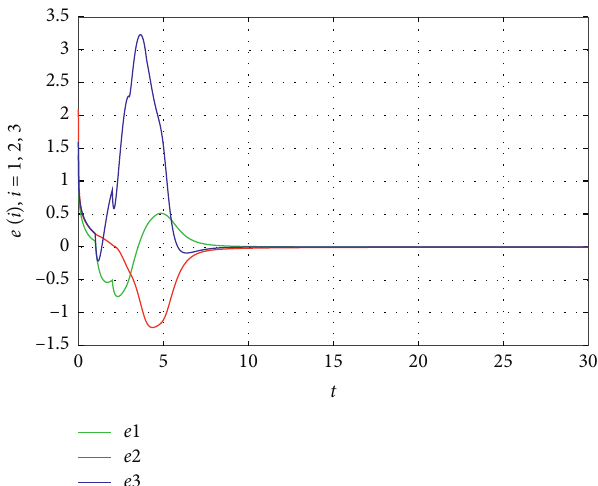
Figure 3: The change processes of error e ( t ) under the initial values (28) and